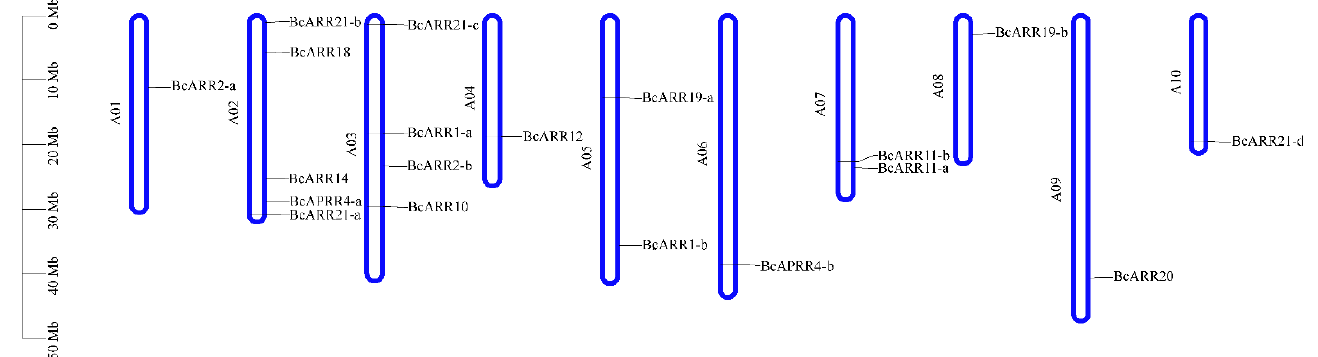
Figure 8. Chromosomal distribution of 19 BcARR-B genes in flowering Chinese cabbage.